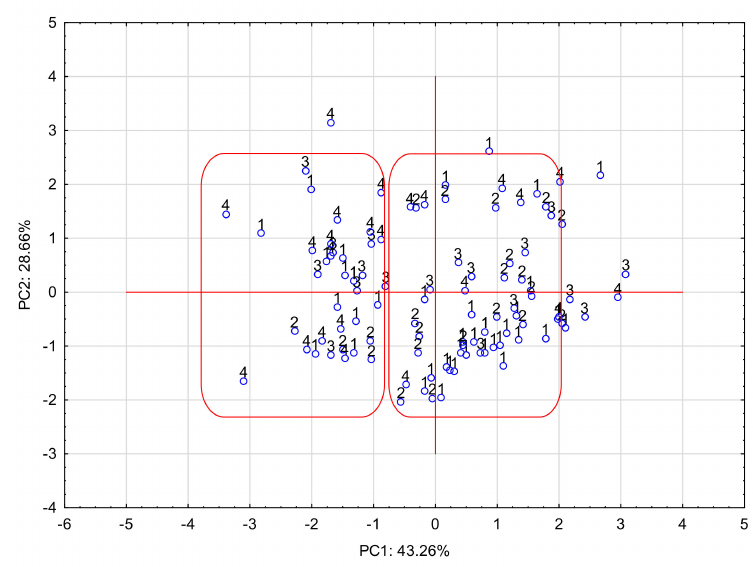
Figure 2. Projection of cases onto the PC1 × PC2